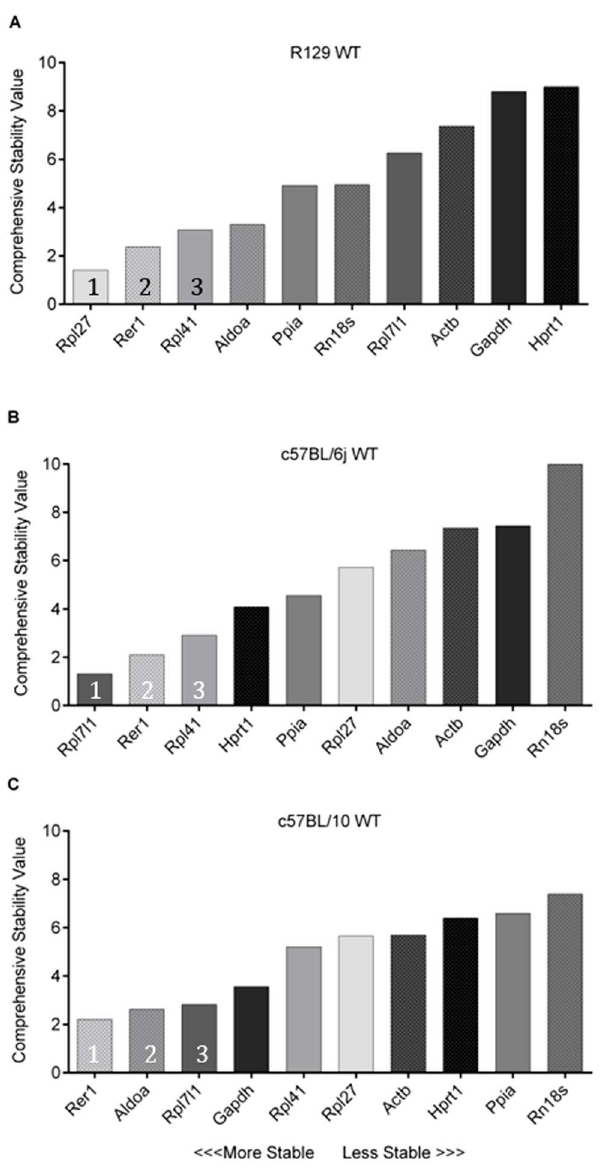
Figure 3. RefFinder analysis comparing the selected reference genes in WT and Actn3 KO mice. A) R129 WT and Actn3 KO mice, B) C57BL/6j WT and Actn3 KO mice, C) C57BL/10 WT and Actn3 KO mice. Columns are shaded light to dark based on R129 gene stability order to represent a shift in position between the C57BL/6j and C57BL/10 strains. 1 – 3 represent the top three genes in each